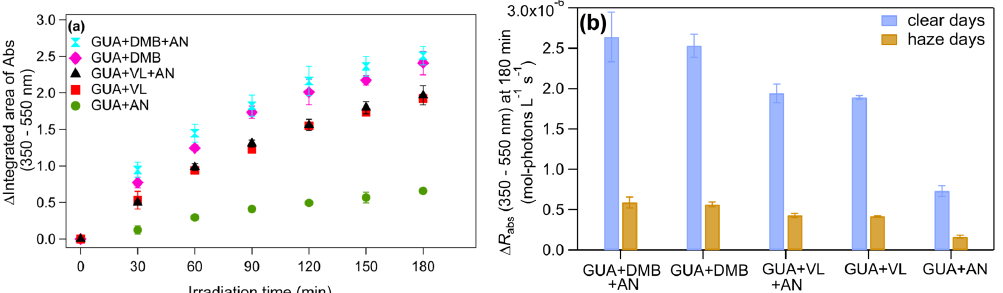
Figure 4. (a) Increase in light absorption throughout 180min of irradiation for all reaction systems studied and (b) change in the rate of sunlight absorption ( (cid:49)R abs ) from 350–550nm at 180min during typical clear and haze days in Beijing, China, for aqSOA from GUA + DMB + AN, GUA + DMB, GUA + VL + AN, GUA + VL, and GUA + AN. Error bars represent 1 standard deviation of triplicate